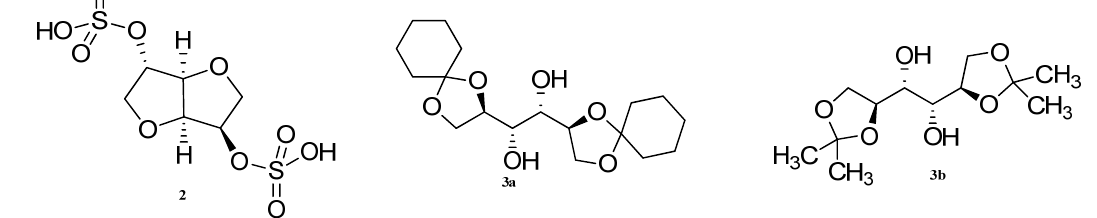
Figure 2. Isosorbide based gelator 2 and mannitol derived gelators 3a and 3b .